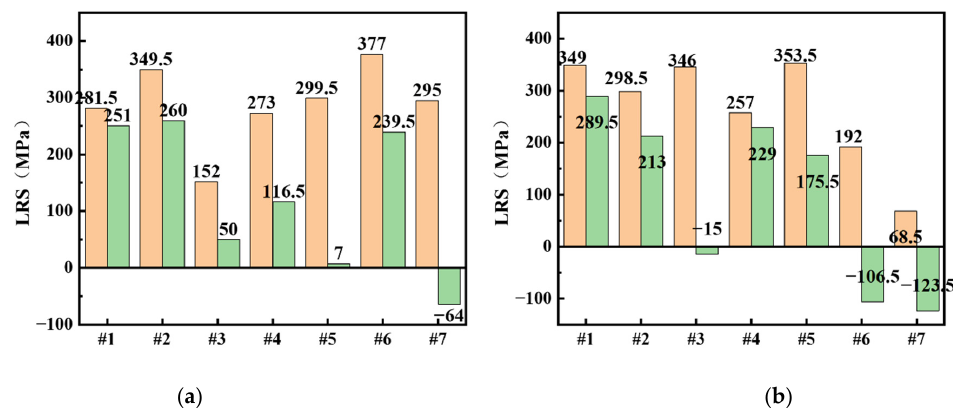
Figure 12. Comparison of peak residual stress release effect. ( a ) Front; ( b ) Back.